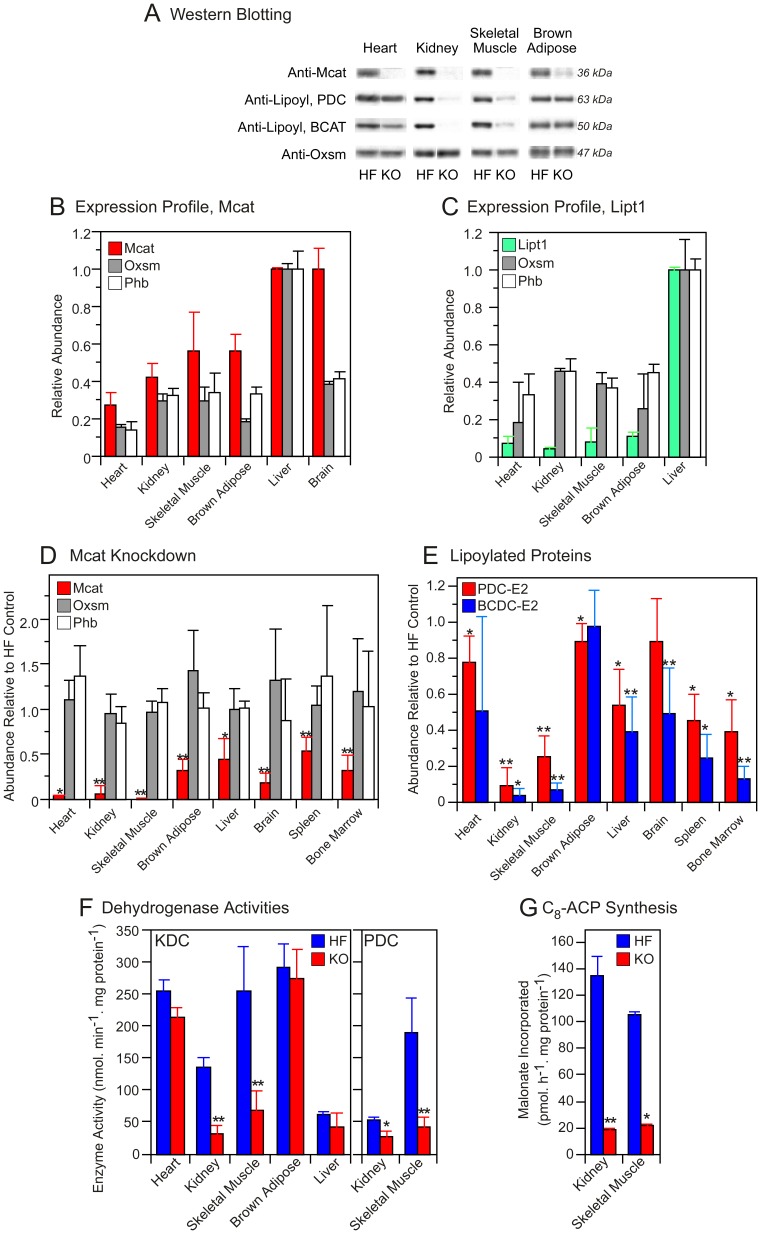
Content and enzyme activity of mitochondrial proteins.A: typical Western blots of mitochondrial proteins illustrating knockdown of Mcat (row 1), lipoylation status of the E2 subunits of PDC and BCDC (rows 2 and 3, respectively), and the content of Oxsm, as a control (row 4). B and C: Expression profiles of Mcat (B) and LipT (C) compared to controls, Oxsm and prohibitin, in mitochondria of HF control mice. The abundance of the proteins is expressed relative to that of liver, which is assigned value of 1.0 (B, n = 2–6; C, n = 1–4). D: Abundance of Mcat and control proteins in mitochondria from KO mice (n = 3–7) relative to the content in HF mice (n = 2–6). E: Lipoylation status of the E2 subunits of PDC and BCDC in KO mice (n = 3–7) relative to HF controls (n = 2–6); mean assigned value of 1.0. F: Activities of KDC and PDC in mitochondria isolated from HF (n, 3–8) and KO mice (n, 4–10). G: Overall activity of the mitochondrial fatty acid synthesis pathway, reported as production of octanoyl-ACP from malonate (n = 2, HF and KO).